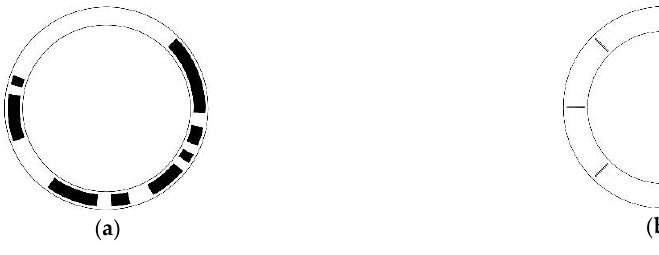
Figure 7. Disc pattern and slit disc of the prototype using a length-8 period-128 STGC: ( a ) Schematic of the coding disc, where the white area indicates “0”, and the black area indicates “1; ( b ) Schematic of the slit disc, where the eight slits are arranged right over the eight reading heads. This disc except the eight slits should be black, but to show the slits clearly we use white instead.